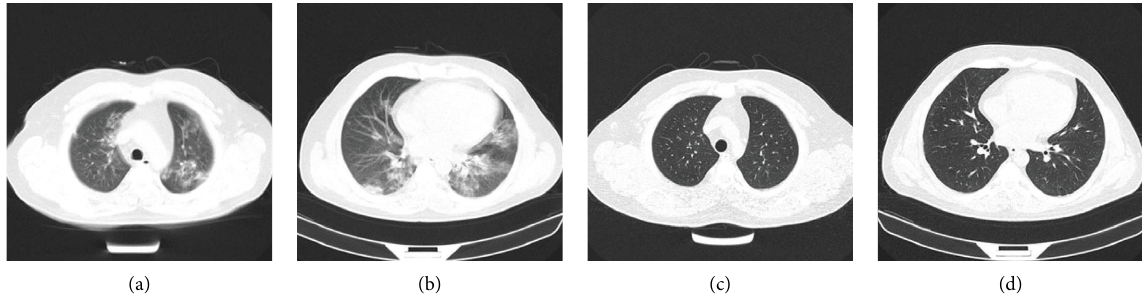
Figure 2: A 32-year-old man with COVID-19 pneumonia treated with oseltamivir, steroid pulse, and hydroxychloroquine. Te on admission chest CT scan shows patchy ground-glass opacities (a, b) with a 10/25 severity score. Te follow-up CT scan about eight weeks after hospital discharge shows no residual opacity. (c,